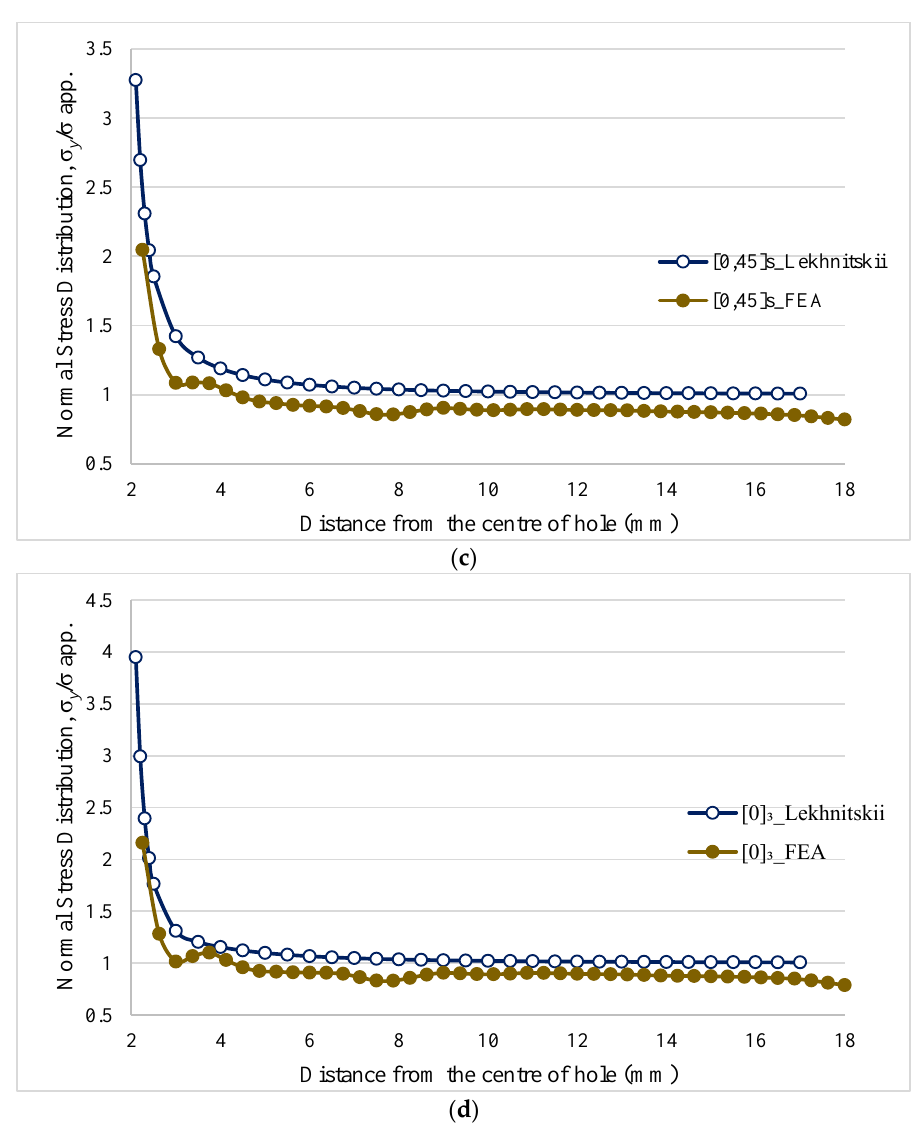
Figure 9. ( a ) Normal stress distribution vs. distance from the center of the hole in 4 mm notched f [0°] 4 laminate; ( b ) Normal stress distribution vs. distance from the center of the hole in 4 mm notched f [45,0°] S laminate; ( c ) Normal stress distribution vs. distance from the center of the hole in 4 mm notched f [0,45°] S laminate; ( d ) Normal stress distribution vs. distance from the center of the hole in 4 mm notched f [0°] 3 laminate.